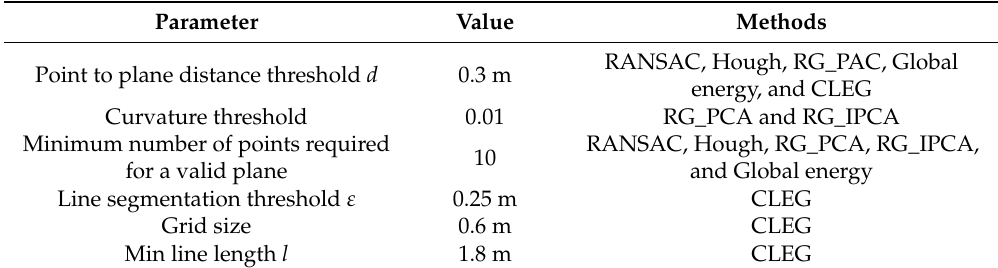
Table 2. Parameters used in the comparison